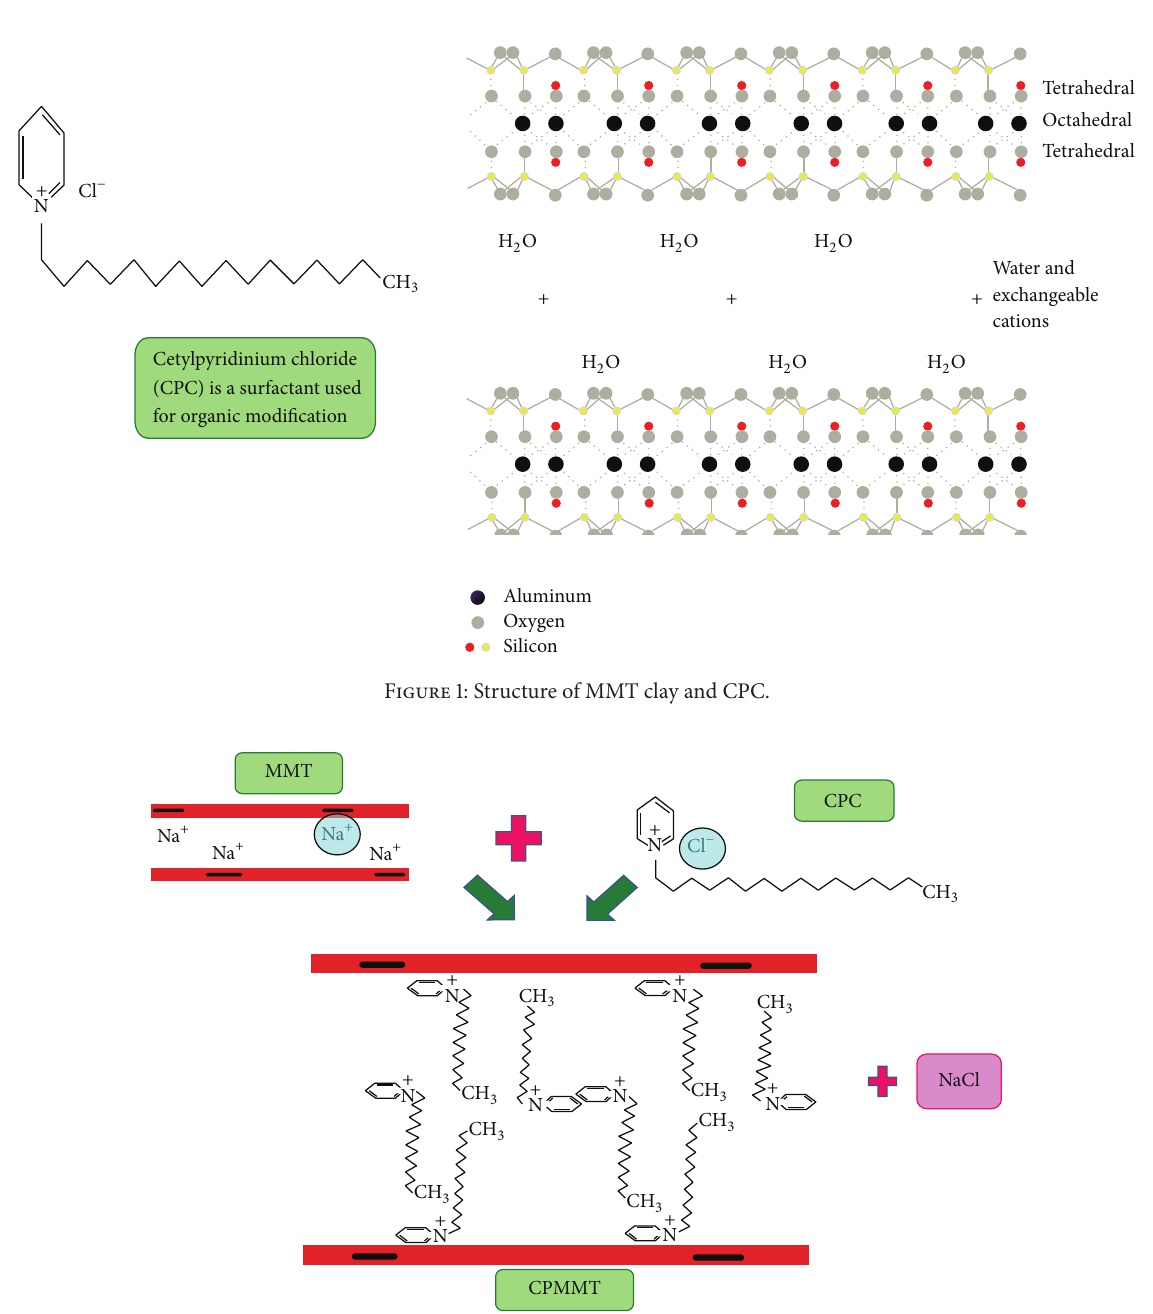
Figure 2: Mechanism of modification of